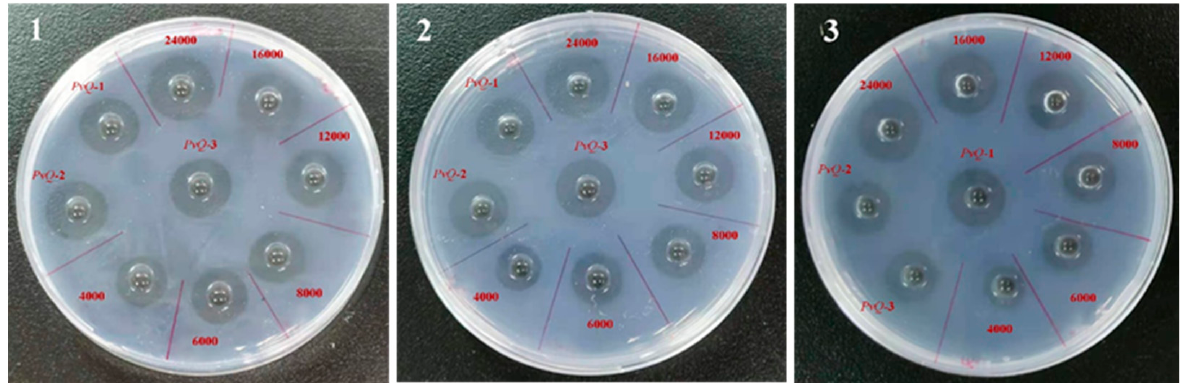
Figure 1. ( a ) HiTrap Q HP chromatogram of P. vulgaris crude extract and ( b ) the fibrogenesis inhibition activity of 27 eluted fractions.